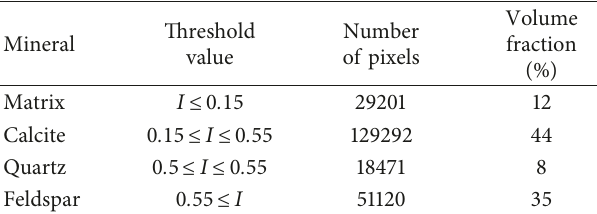
Figure 4: The intensity component ( I ) histogram of the image in Figure 1. Table 1: Threshold values and volume fractions of the